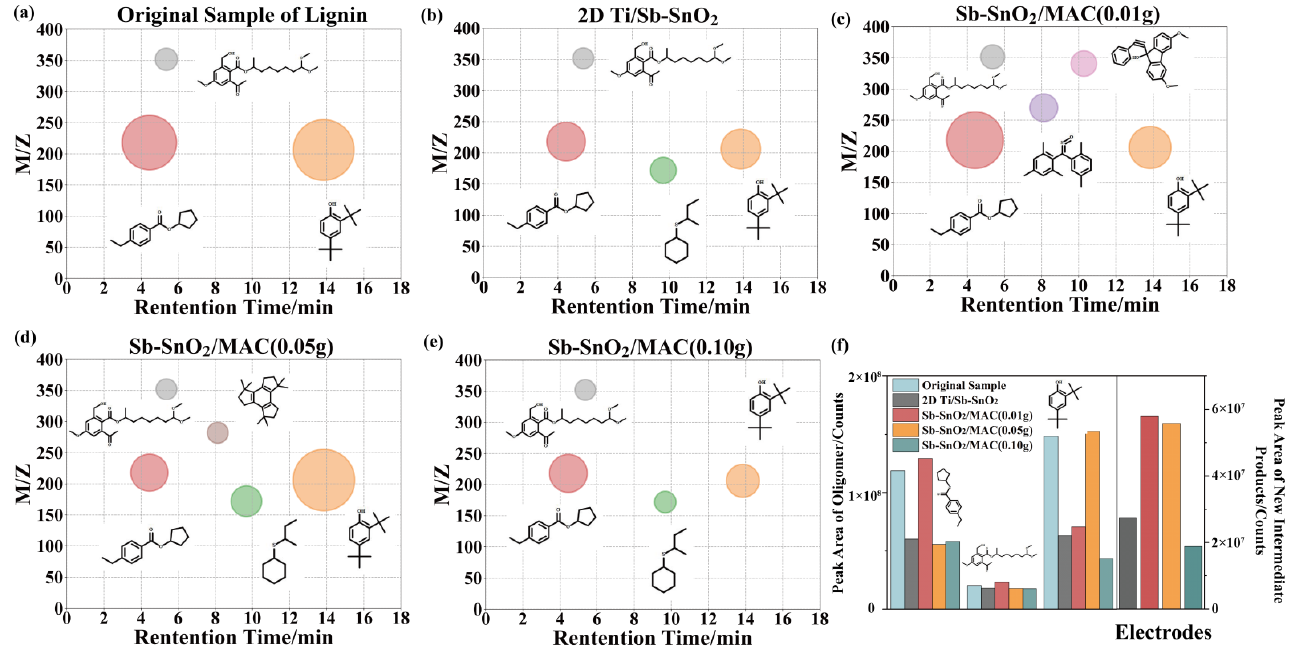
Figure 6. Lignin degradation results under current density of 20 mA · cm − 2 (initial lignin concentration of 100 ppm, anode area of 9 cm 2 , solution volume of 250 mL, supporting electrolyte of 125 ppm of Na 2 SO 4 , room temperature) before and after 3 h electrolysis ( a – e ) Bubble diagram of original lignin sample or intermediate products according to their GC peak area (( a ) Original sample of lignin; ( b ) 2D Ti/Sb-SnO 2 ; ( c ) Sb-SnO 2 /MAC(0.01 g); ( d ) Sb-SnO 2 /MAC(0.05 g); ( e ) Sb-SnO 2 /MAC(0.10 g); ( f ) Accumulative GC peak area columns of oligomers in original sample and degradation samples (left part) and new generated intermediate products after degradation (right part).